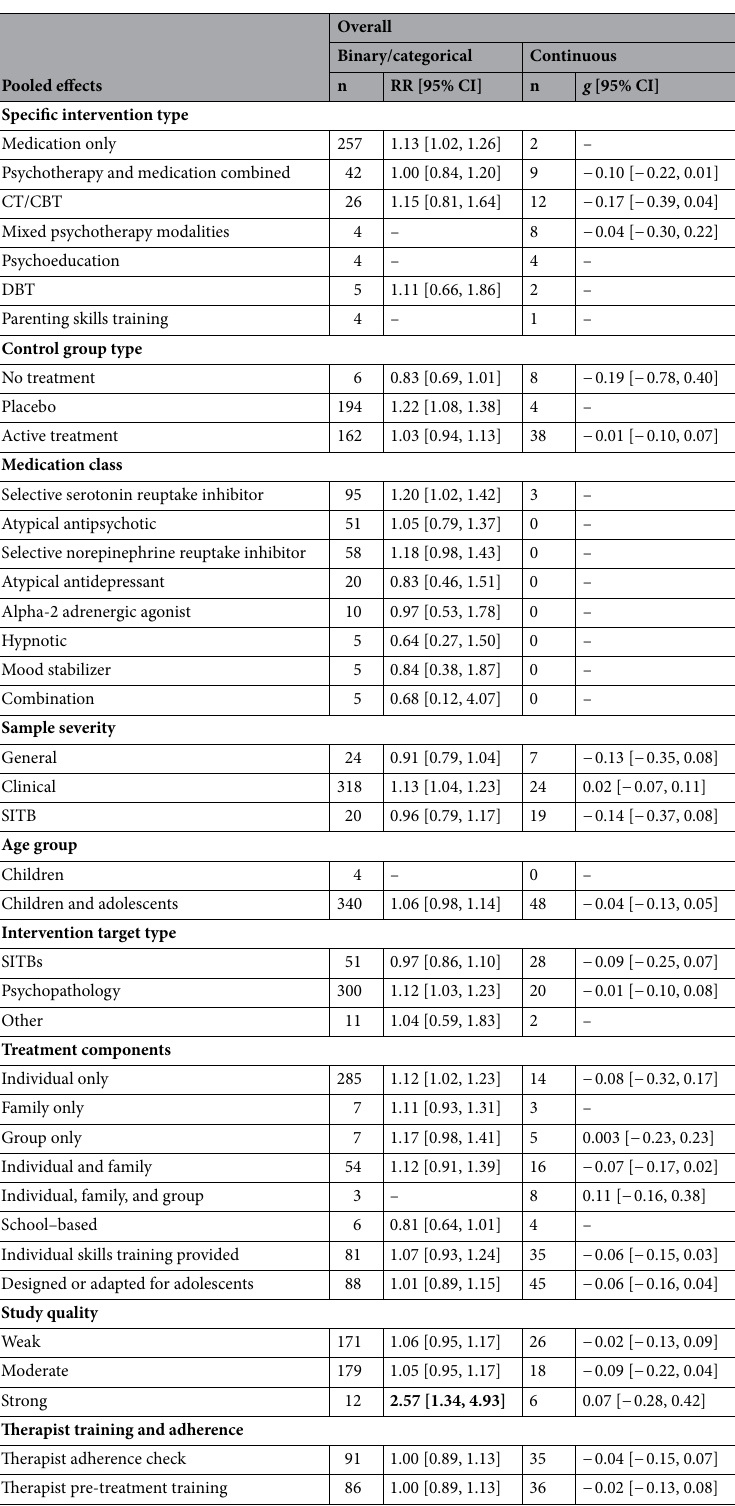
Table 4. Moderator analyses for categorical moderators. Estimates were not reported for analyses involving fewer than five effect sizes to improve the reliability and accuracy of estimates. n number of effect sizes, RR weighted mean risk ratio, 95% CI 95% confidence interval. Dashes indicate unavailable information. Bold indicates an effect estimate which is significantly different from pooled effects (i.e., nonoverlapping confidence